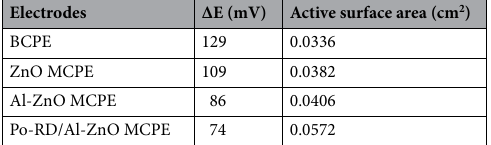
Table 2. Active surface area for electrodes.